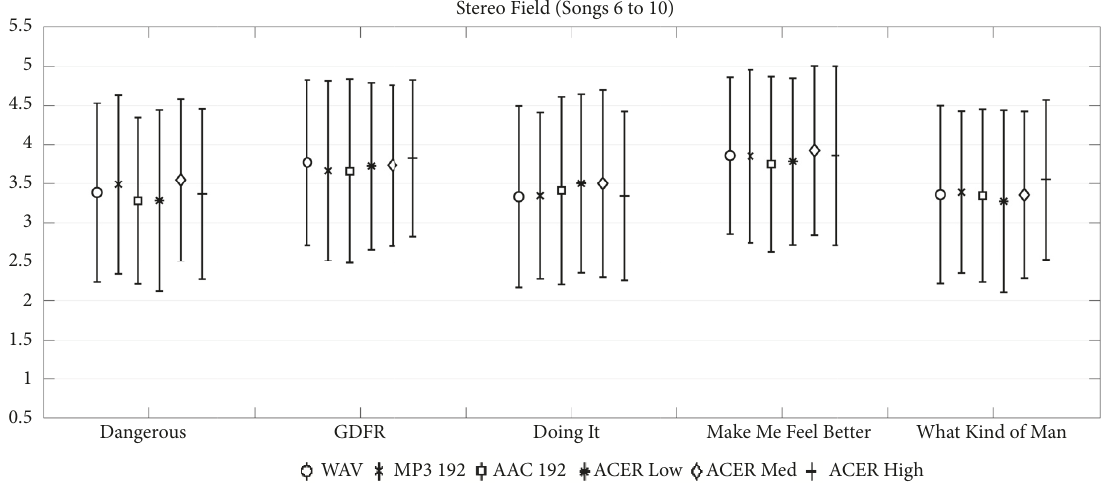
Figure 5: Stereo field results (songs 6 to 10). A score of 1 represents narrow and imprecise and a score of 5 represents wide and precise.